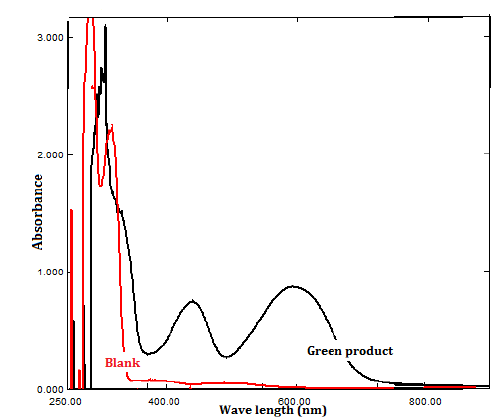
Figure 3. Absorption spectra of 25 μg/mL of decomposed CDE treated as described procedure and measured against blank, and the blank measured against water.